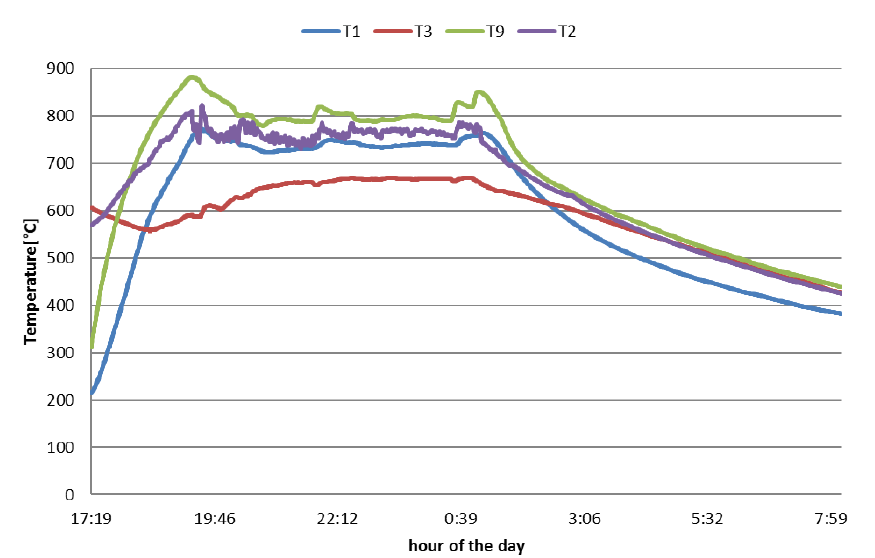
Figure 4. Temperature trends inside the reactor with focus on the steady-state time window. Legend temperatures in accordance with the positions are shown in Figure 2.